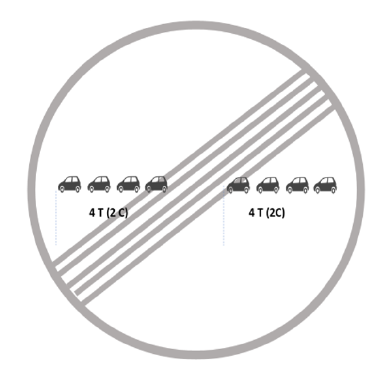
Figure 7. End of platoon zone